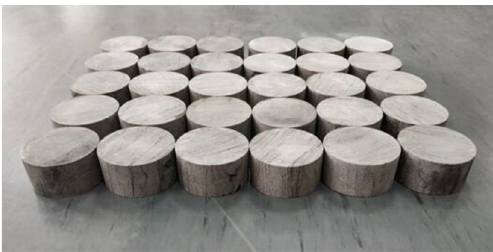
Figure 1: Sandstone samples under impact loading test. Table 1: The basic mechanical parameters of the tested sandstone.